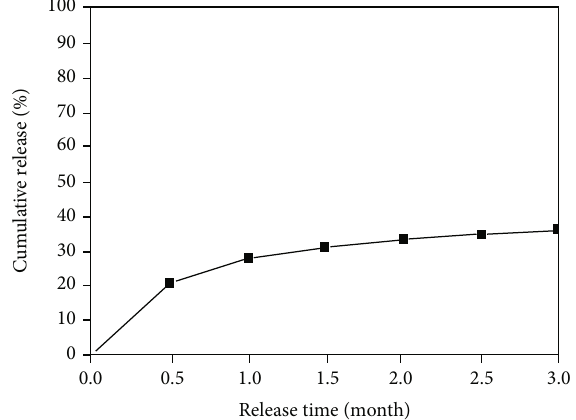
Figure 67: Release of fl ower garland fragrance from polyacrylate/ para ffi n microcapsules in air [182].